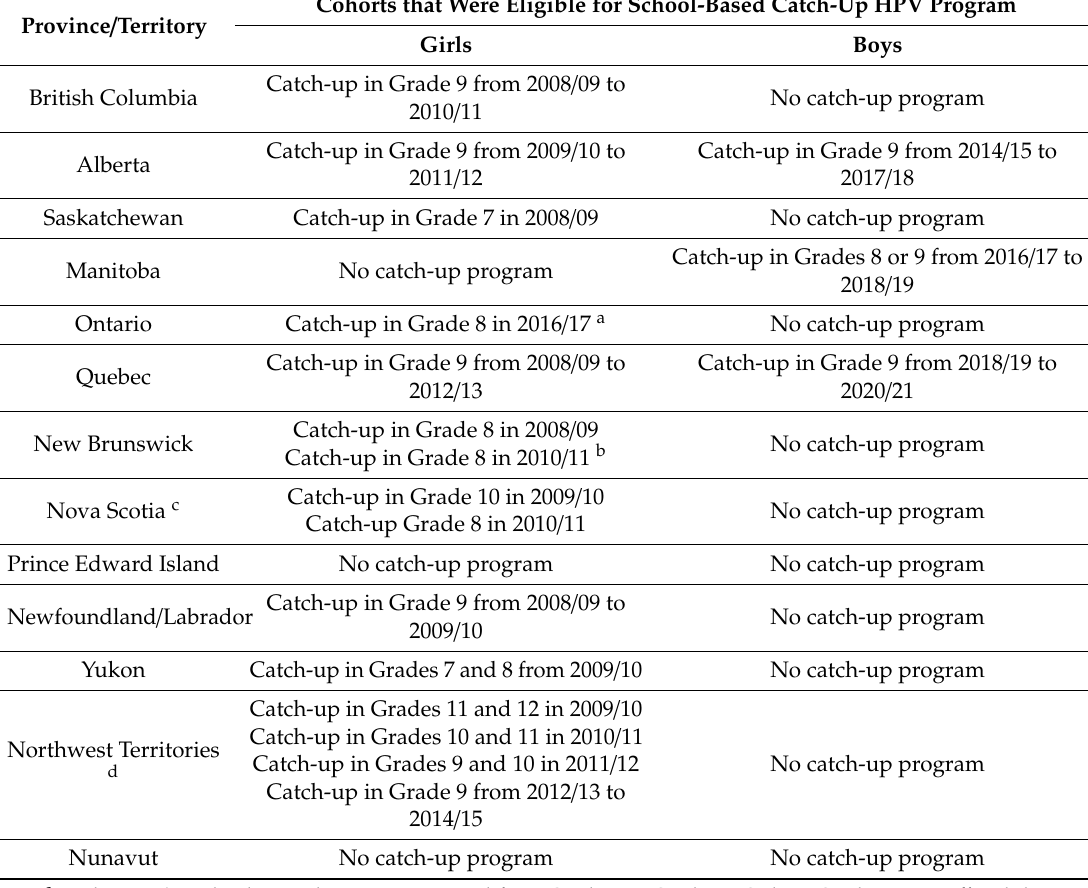
Table 2. School-based temporary catch-up HPV vaccination programs. Province /